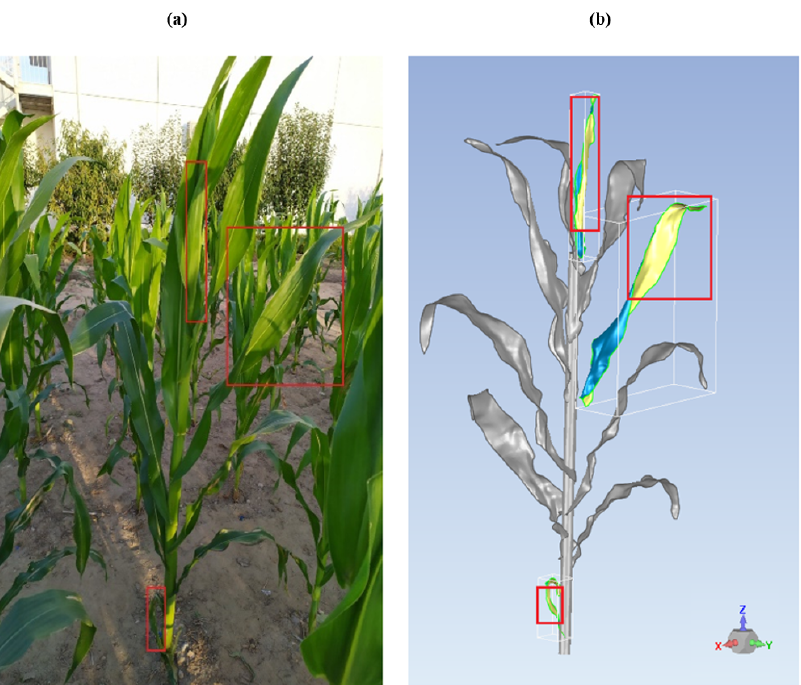
Figure 5. Parts of the leaves with zenith angles higher than 90 ◦ for the third stage. ( a ) real photograph of the plant, ( b ) structure reconstructed from the point cloud.